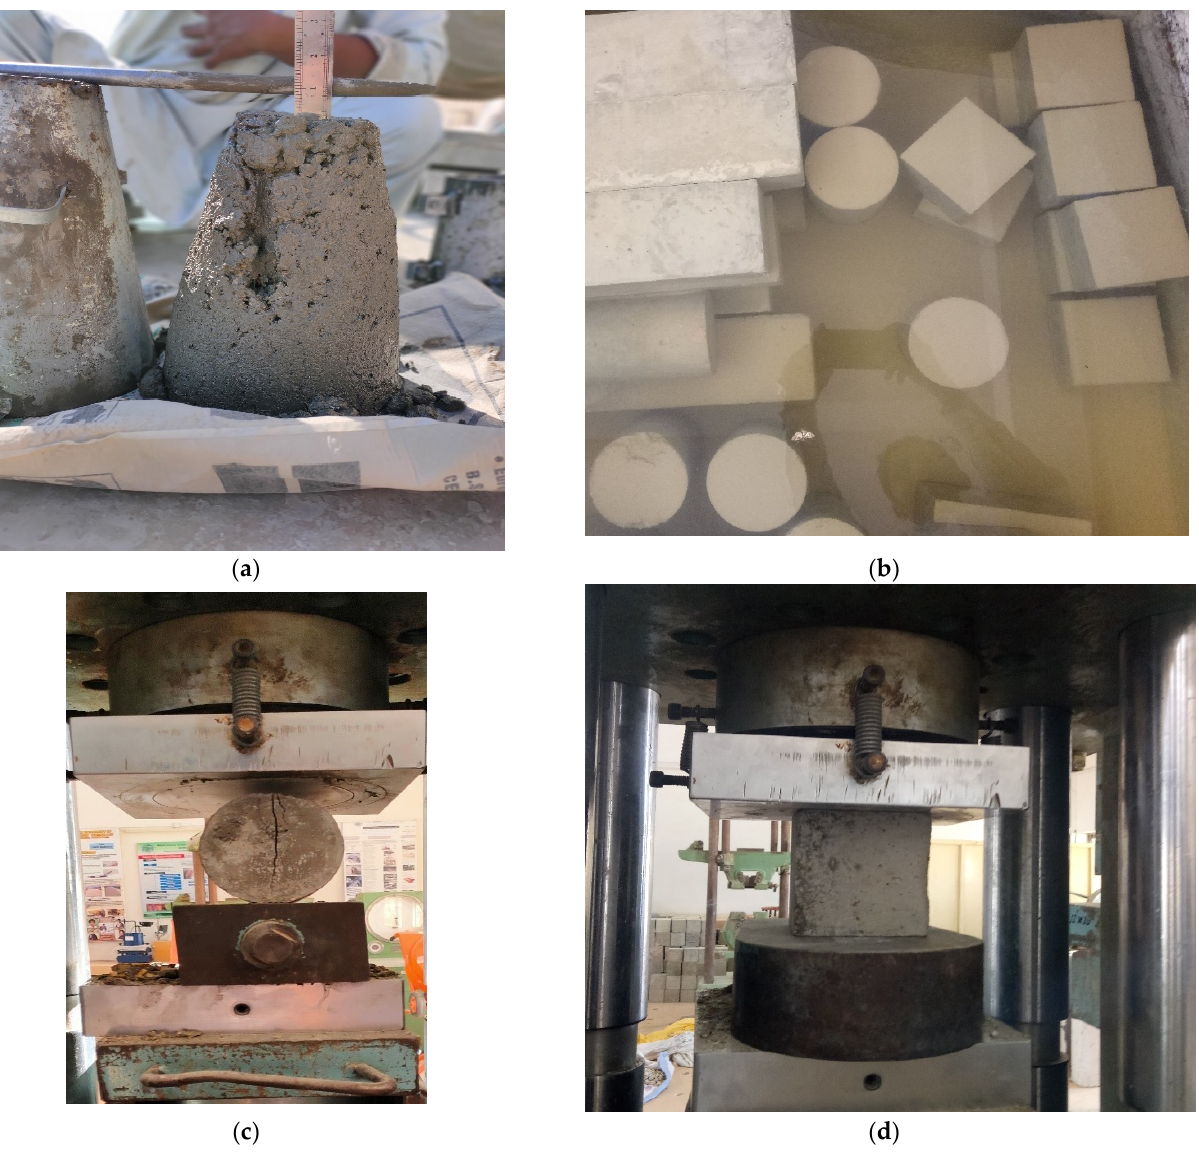
Figure 3. Experimental tests set-up: ( a ) slump test; ( b ) water curing tank; ( c ) split tensile strength test; ( d ) compressive strength test.